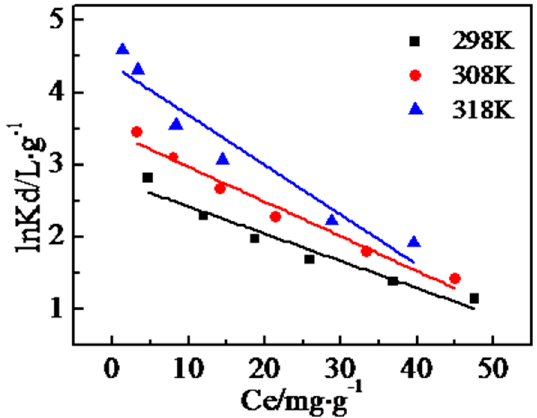
Figure 5. The linear plots of ln K d vs. C e of Hg(II) onto MPy-600. The line graphs of ln K d vs. C e of Hg(II) adsorption onto MPy-600 at different